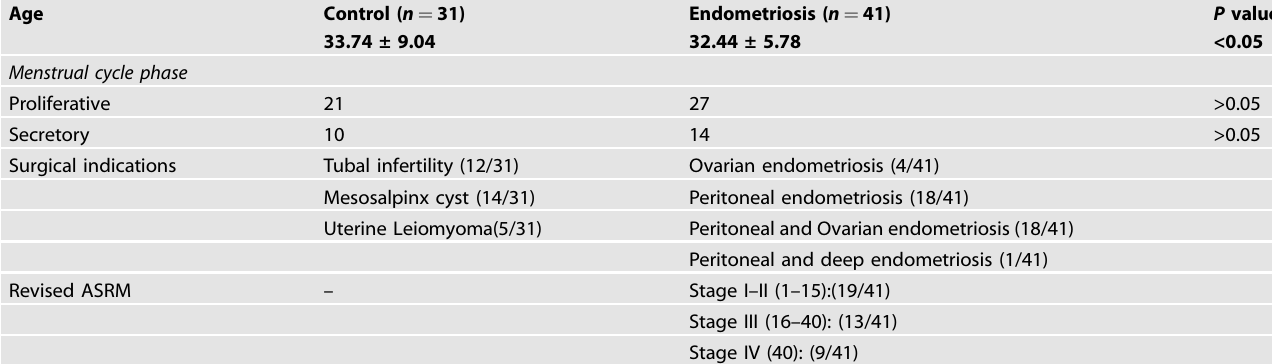
Table 1. Clinical description of endometriosis and control